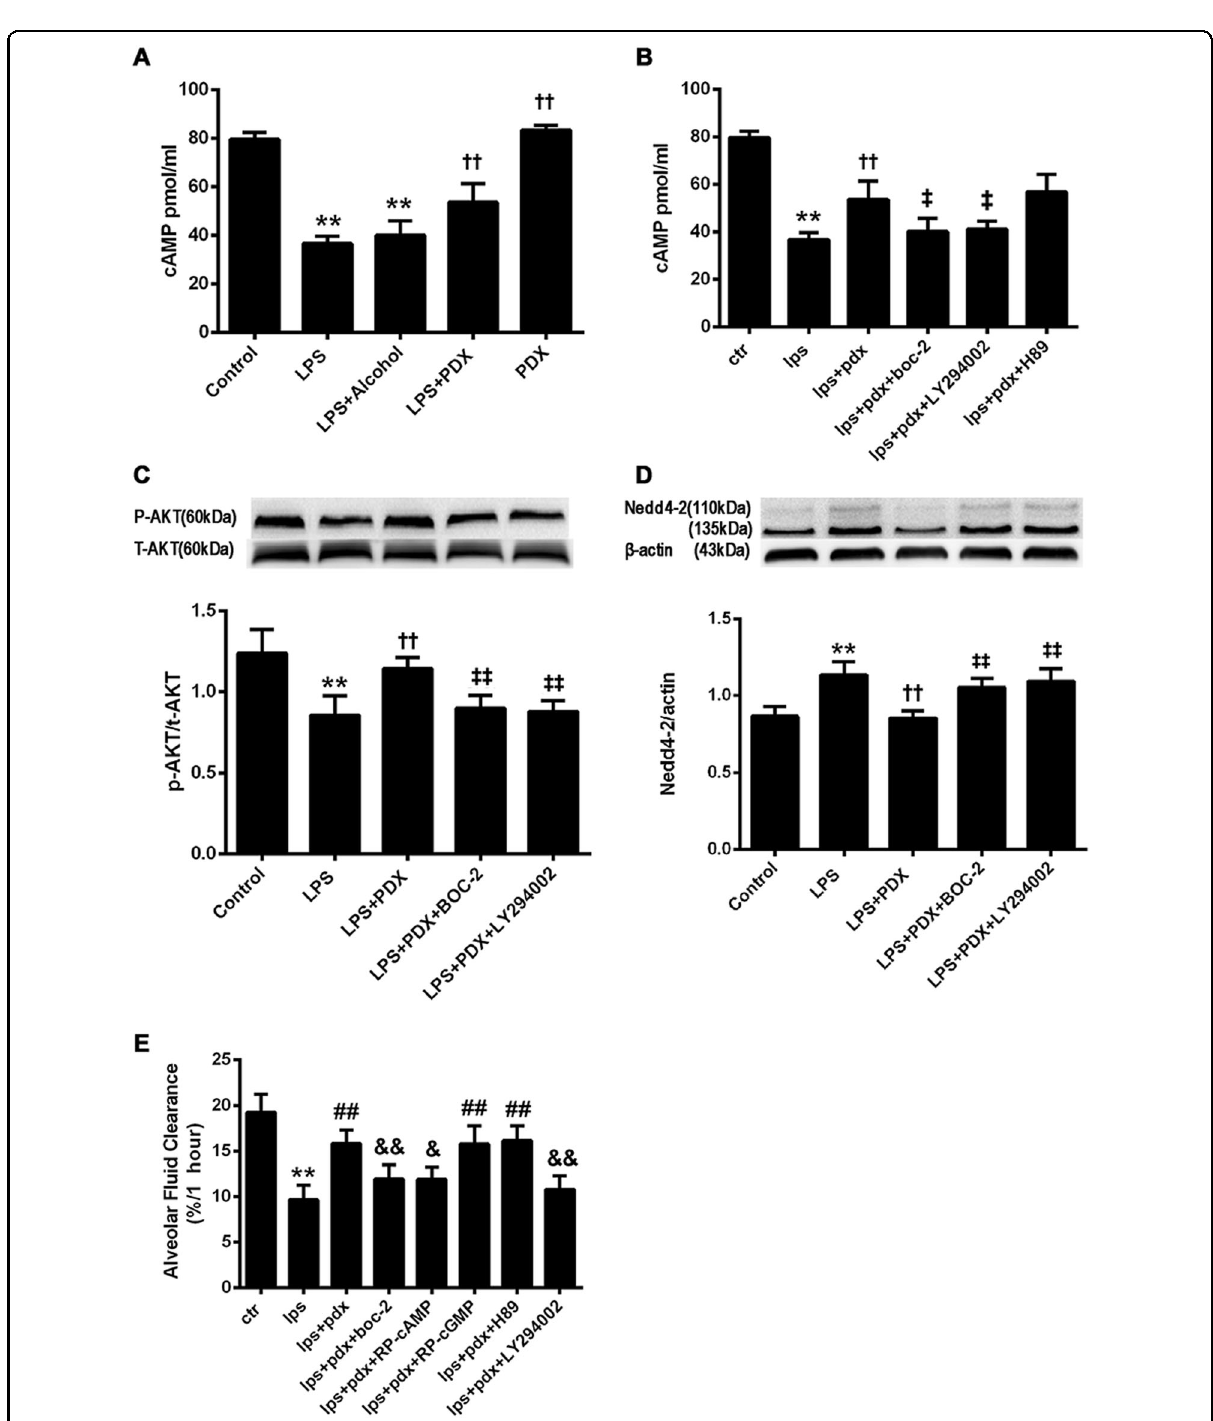
Fig. 4 Alveolar fl uid clearance improvements by protectin DX were partly dependent on ALX, cAMP, and the PI3K pathway in vivo. Protectin DX (5 µg/kg) and BOC-2 (ALX receptor inhibitor, 600 ng/kg), LY294002 (PI3K inhibitor, 3 mg/kg), Rp-cAMP (5 mg/kg), Rp-cGMP (5.5 mg/kg) or H89 (10 mg/kg) were co-injected into the caudal veins of Sprague-Dawley rats 8 h after LPS (14 mg/kg) stimulation; then, intratracheal instillation of a 5% albumin solution containing Evans blue-labeled albumin (5 ml/kg) through a tracheostomy to the left lung was performed to measure alveolar fl uid clearance ( e ), and right lung tissues were harvested to measure cAMP concentrations by using ELISA kits ( a , b ) and phosphorylated Akt ( c ) and Nedd4-2 ( d ) protein expression levels by western blotting. The data are presented as the mean ± SD. n = 8. PDX protectin DX. Alcohol was the solvent for protectin DX. ** p < 0.01 versus the control group; †† p < 0.01 versus the LPS group; ‡ p < 0.05, ‡‡ p < 0.01 versus the LPS + PDX